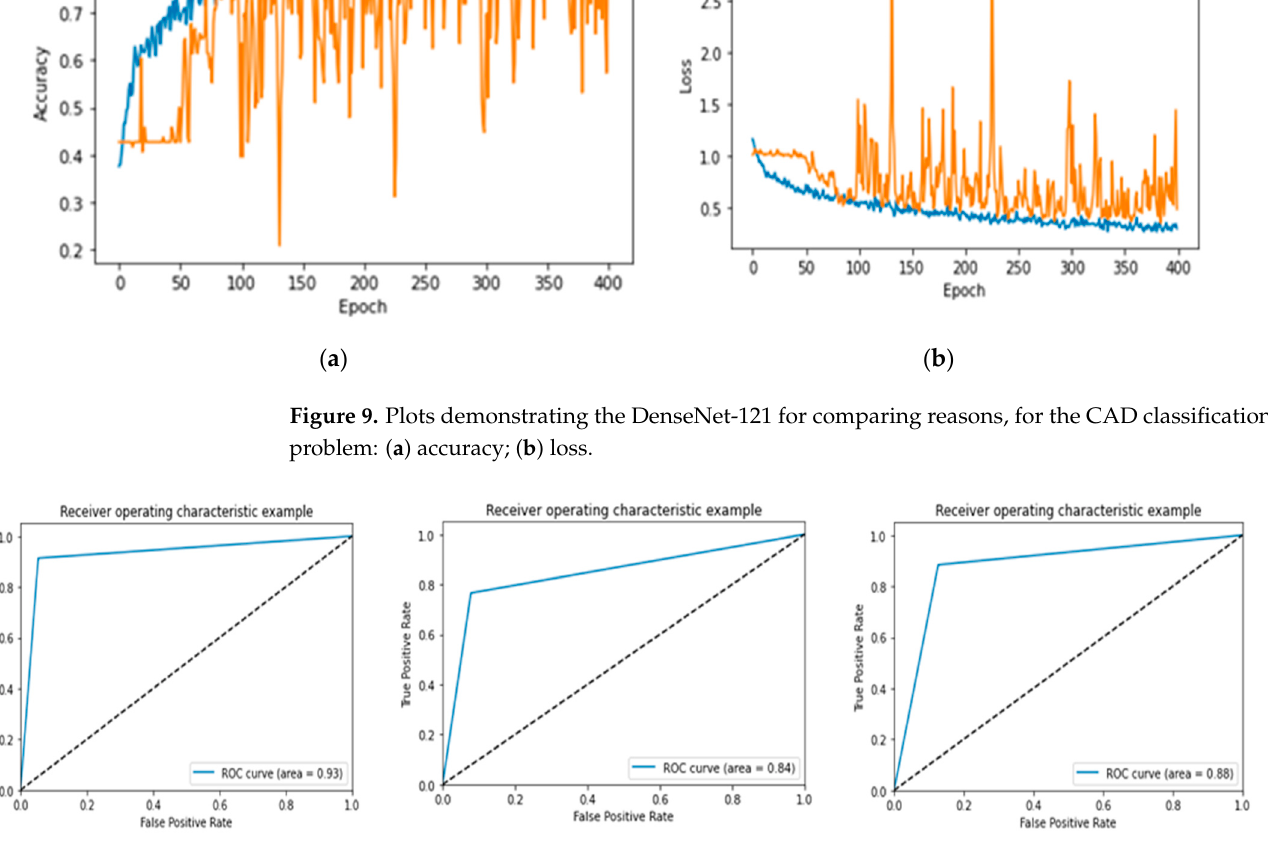
Figure 10. Performance of Receive Operating Characteristic (ROC) curve for proposed RGB: ( a ) infarction; ( b ) ischemia; ( c ) normal.